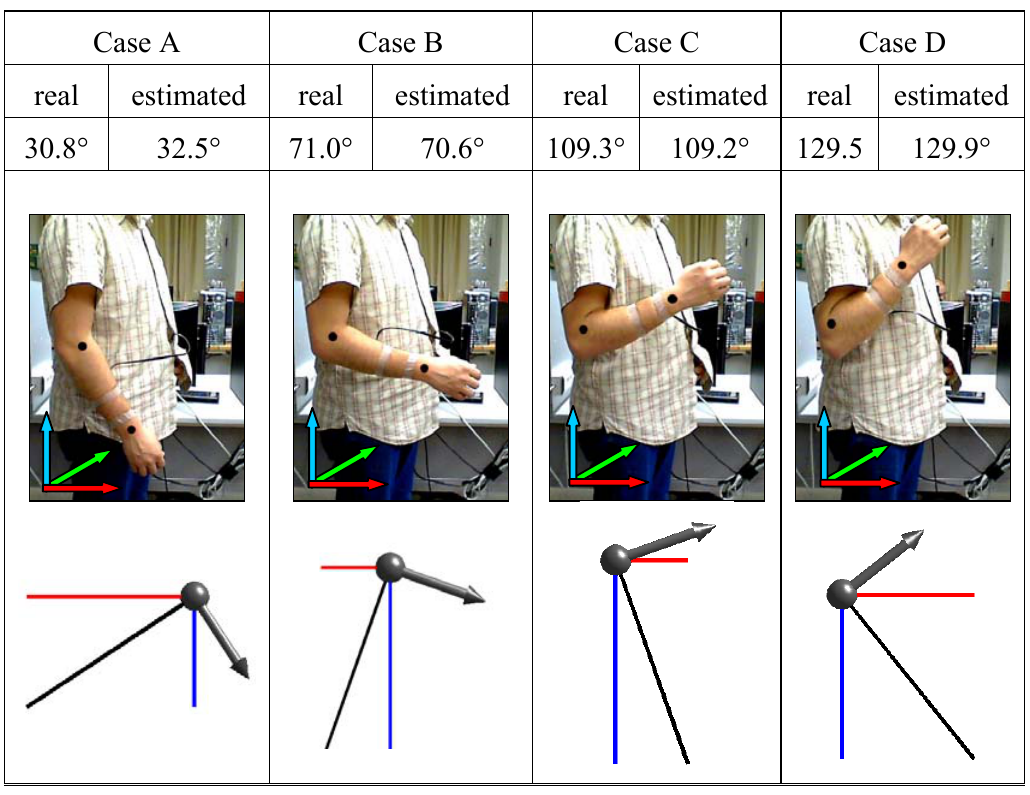
Table 1. Detail of different vertical inclinations measured with the accelerometer when raising the user’s